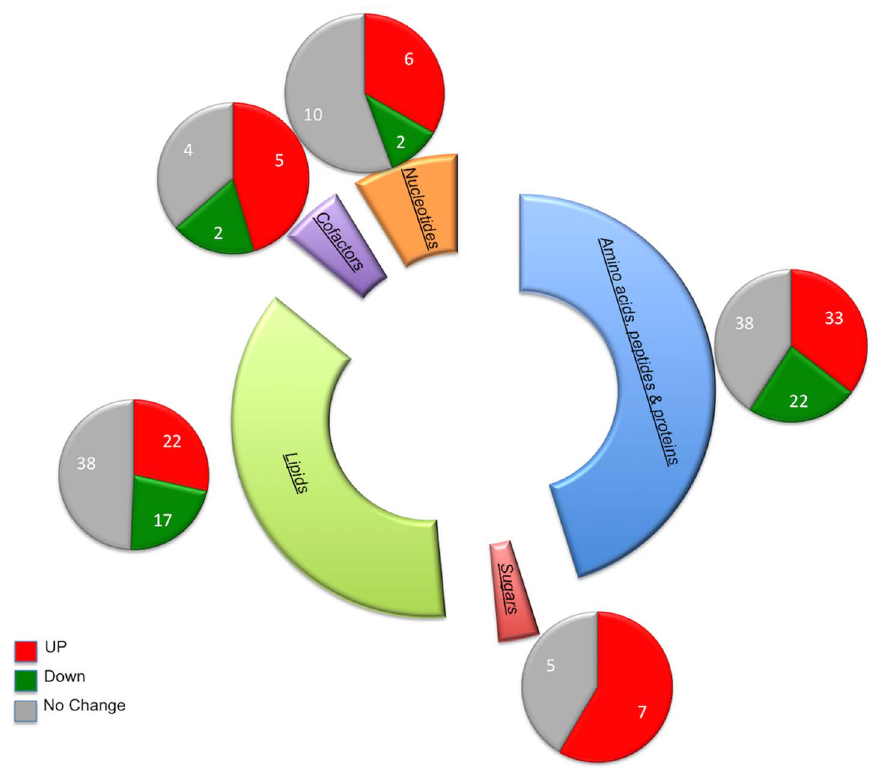
Figure 1. Distribution of the metabolomics data with colors depicting the levels of metabolites.